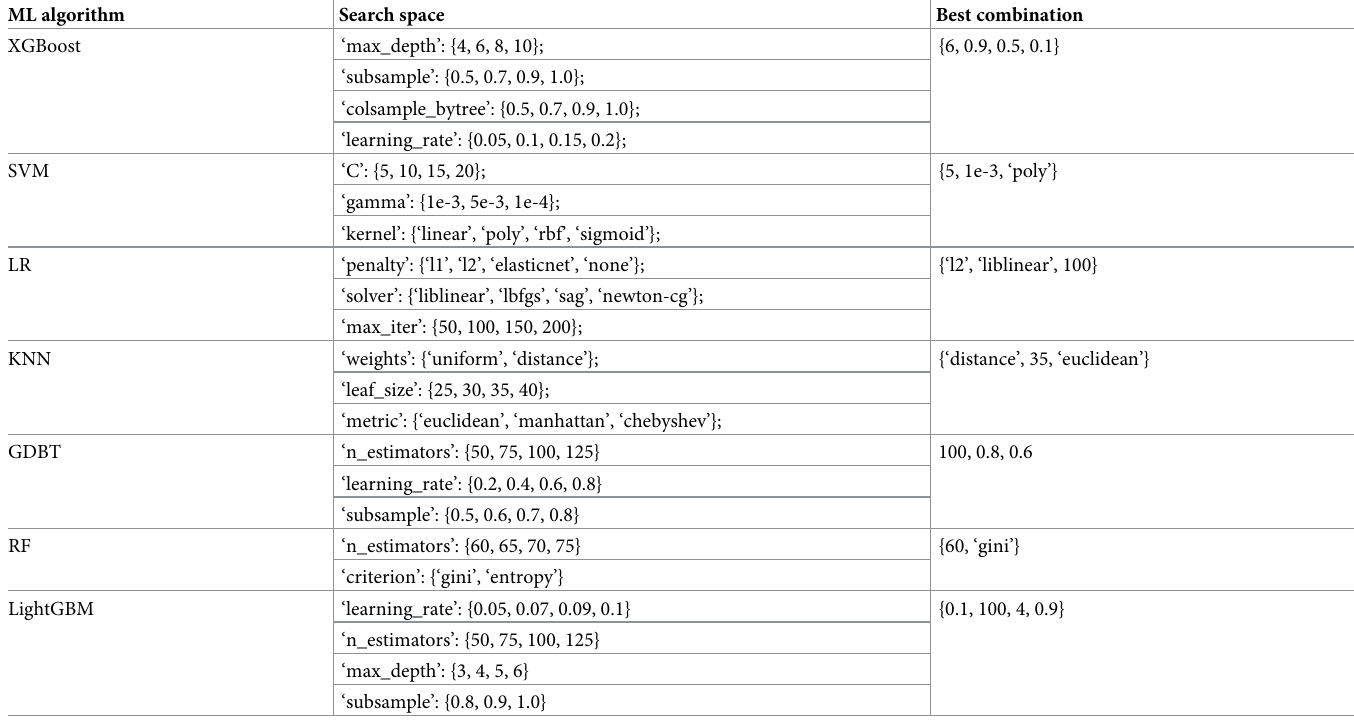
Table 3. Reference parameters for each of the machine learning algorithms. ML algorithm Search space